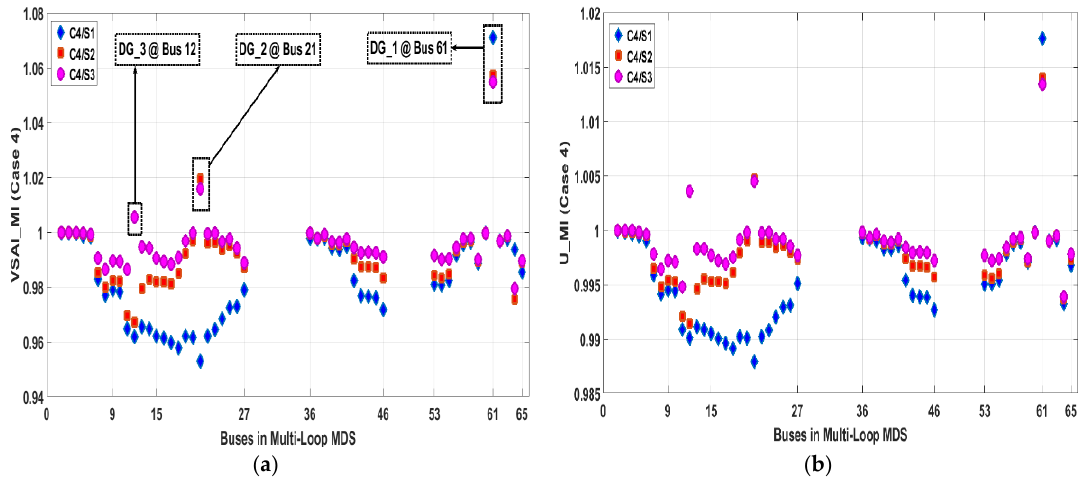
Figure 17. Case 4 for 69-bus MDS (L_Min) ( a ) VSAI trend (based on ideal MDS) for VSAI_MI-LMC; and ( b ) U-profile trend for VSAI_MI-LMC, based planning approach (DG operating @ pf = 0.82 ± 2.5%).